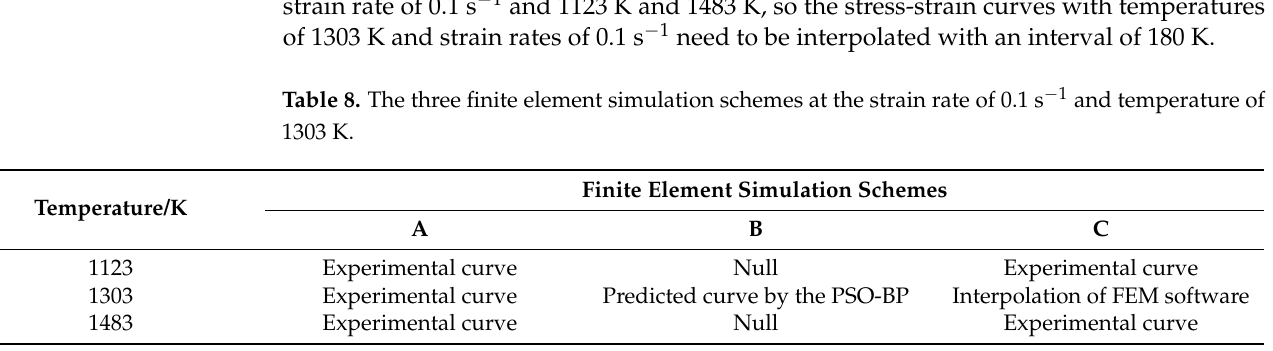
Table 8. The three fi nite element simulation schemes at the strain rate of 0.1 s − 1 and temperature of 1303 K.